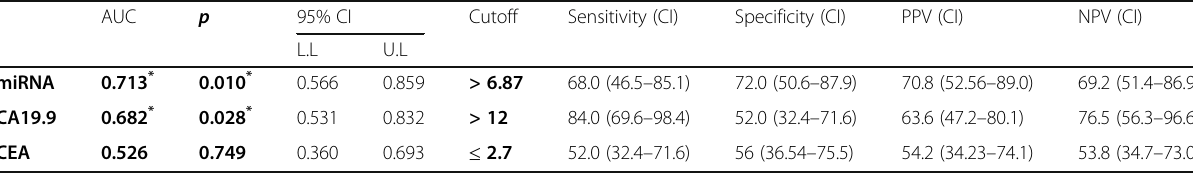
Table 6 Agreement (sensitivity, specificity) for different parameters to predict patients with stage IV from stage II + III AUC